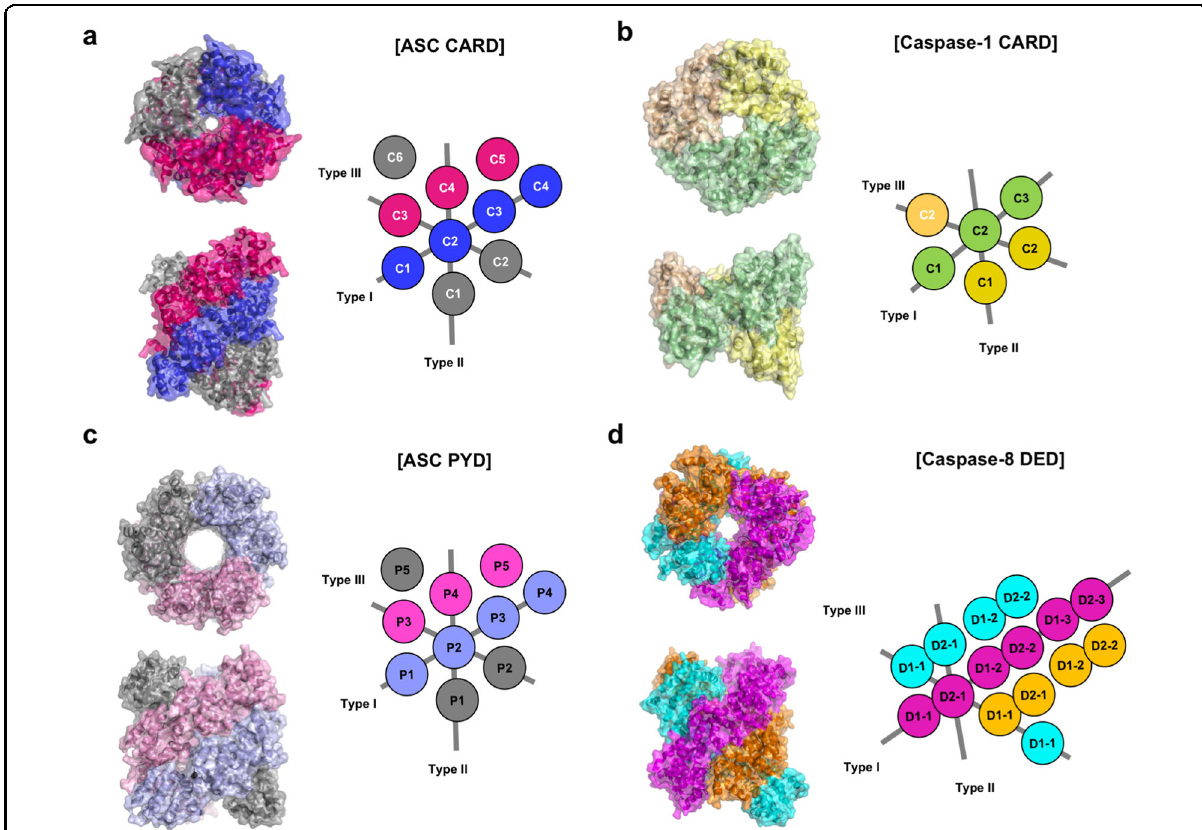
Fig. 2 Helical fi lament structure of the death domain (DD) superfamily. Helical fi lament structures of a the ASC caspase recruitment domain (CARD), b caspase-1 CARD, c the ASC pyrin domain (PYD), and d the caspase-8 death effector domain (DED) are represented. The surface structures are shown in the left panel from a topside view. A schematic planar diagram is shown in the right panel. The three different types of interactions used for helical fi lament formation are designated type I, type II, and type III. C and P in the schematic model indicate CARD (C) and PYD (P), respectively. The tandem DEDs of caspase-8 that produce a helical fi lament structure are separately indicated by D1 for the fi rst DED and D2 for the second DED in the schematic